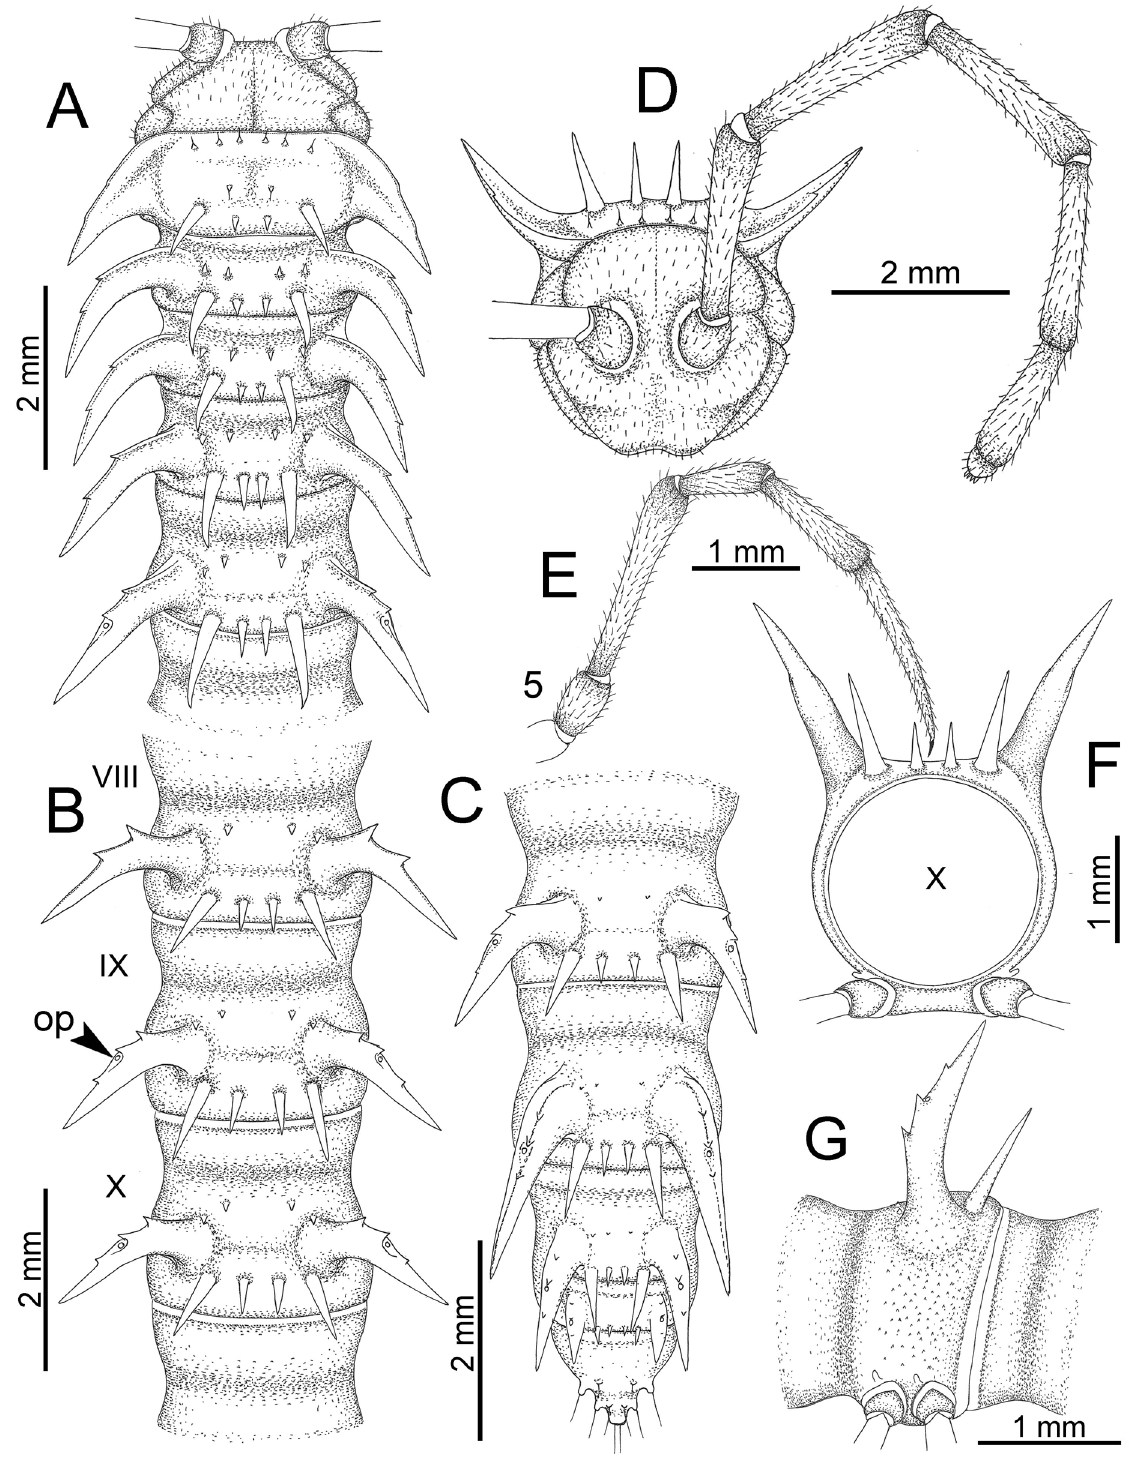
Fig. 13. Nagaxytes erecta Srisonchai, Enghoff & Panha gen. et sp. nov., ♂, paratype (CUMZ- pxDGT00002). A . Anterior body part. B . Body rings 8–10. C . Posteriormost body rings and telson. D . Head and antenna. E . ♂ leg 5 (right). F – G . Midbody